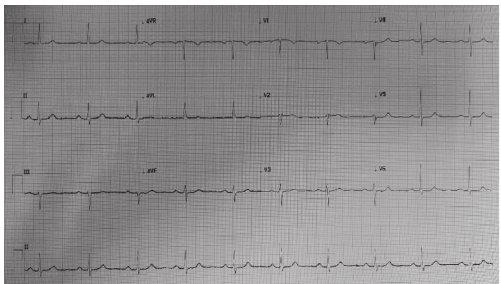
Figure 1: Preoperative electrocardiogram (ECG) for the patient performed in the anesthesia